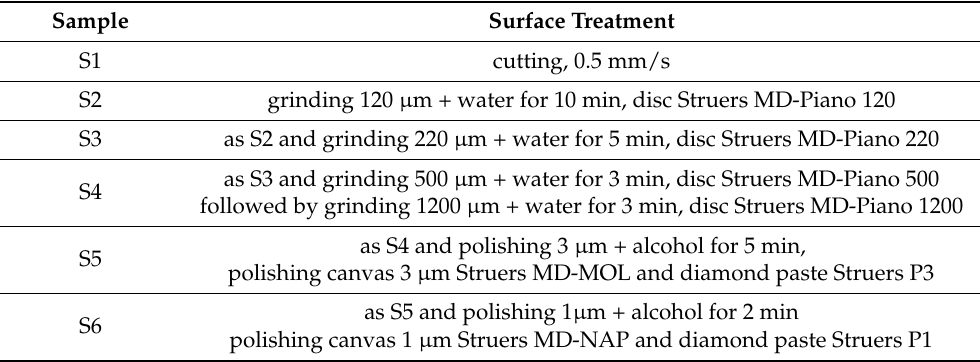
Table 1. List of primary samples treated by successive grinding and polishing.